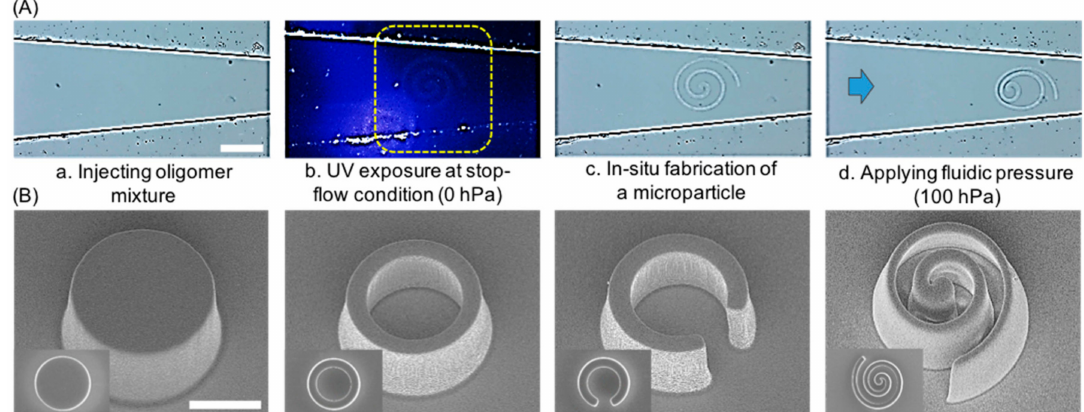
Figure 2. In-situ fabrication of polymeric microparticles in a tapered microfluidic channel for in-situ deformability measure- ment. ( A ) An in-situ microparticle fabrication process. (scale bar: 100 µ m) ( B ) Scanning electron microscopy images of the fabricated microparticles. (scale bar: 75 µ